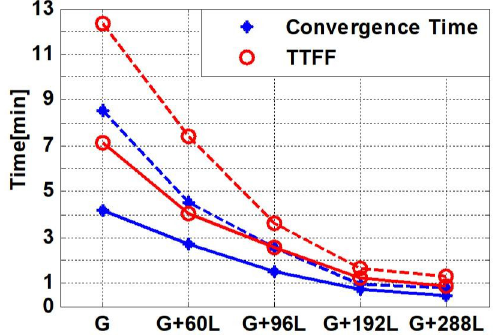
Figure 9. The solid lines describe the average convergence time and TTFF of five medium-baseline solutions with the augmentations of different LEO constellations, and the similar indexes of five long-baseline solutions are shown in dashed line.